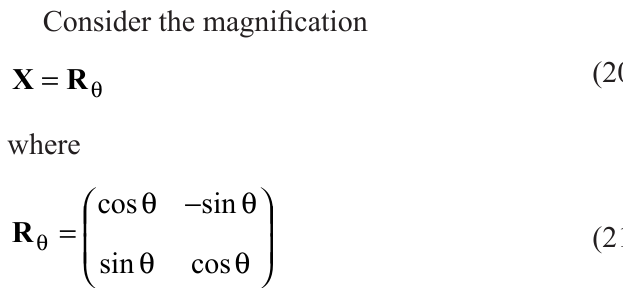
Figure 5 The image I of an object O under the singular asym - metric magnification  terpreted as symmetric magnification 0 by clockwise rotation through 90 ° 30 .